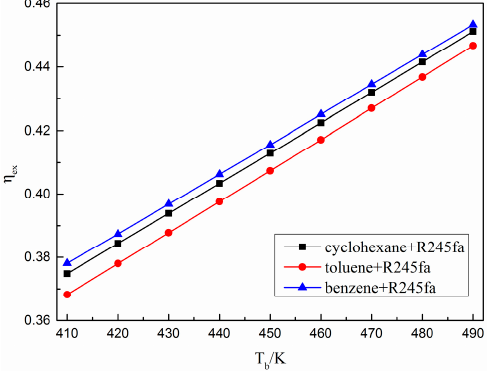
Figure 10. Effect of T b on the exergy efficiency.